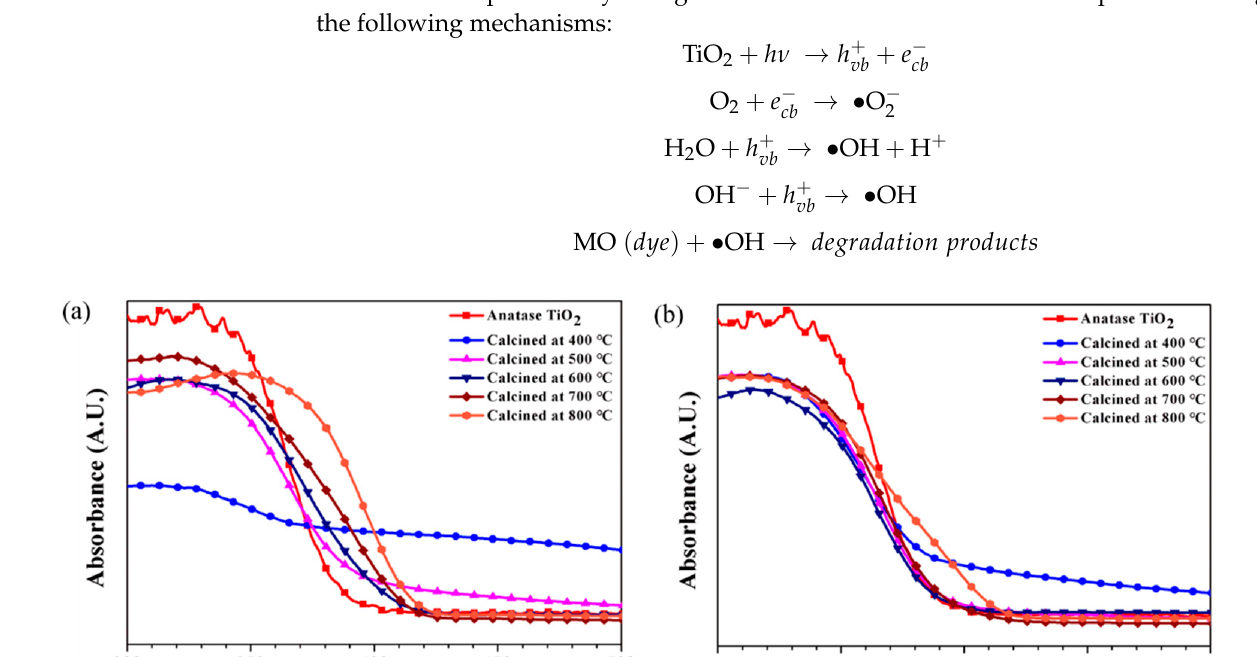
Figure 10. MO decomposition rate of different calcination temperatures ( a ) CS1 and ( b ) CS2. Figure 11 shows the decomposition efficiency of organics obtained by conducting MO decomposition experiments on hollow titania particles via heat treatment tempera- ture. The decomposition efficiency was calculated by the concentration of the remaining MO through UV irradiation for 3 h. In the case of MO, it showed a decomposition capacity of ~5%, and in the case of similar efficiency, it was observed at a high ratio (>90%) of amorphous and non-crystallized amorphous and rutile. Furthermore, in the case of parti- cles heat-treated at 800 °C, CS1 and CS2 have low anatase fractions, and in the case of CS3,